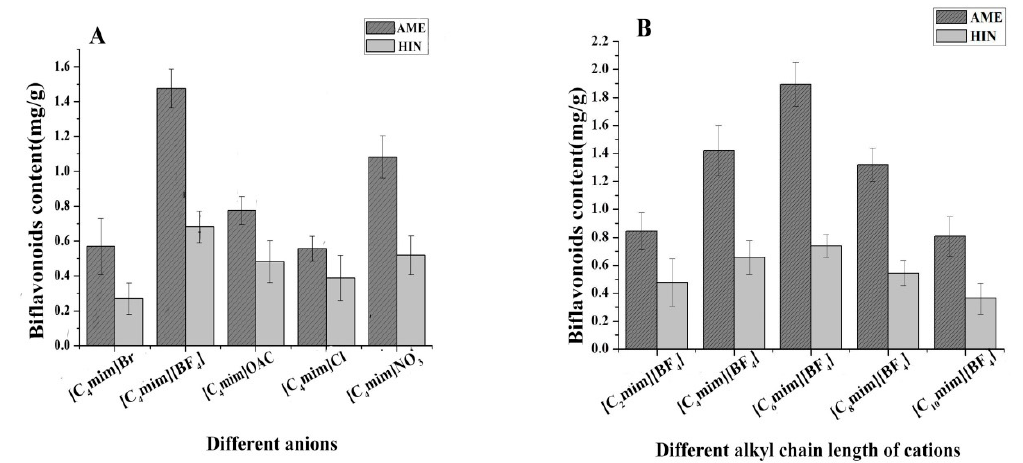
Figure 2. Effect of the ( A ) IL anions and ( B ) IL cations for two biflavonoids content from S. sinensis.